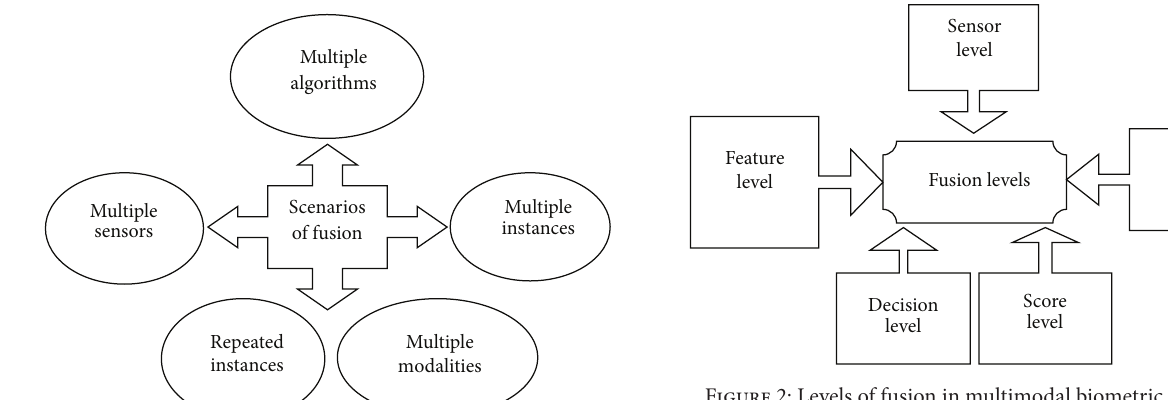
Figure 2: Levels of fusion in multimodal biometric